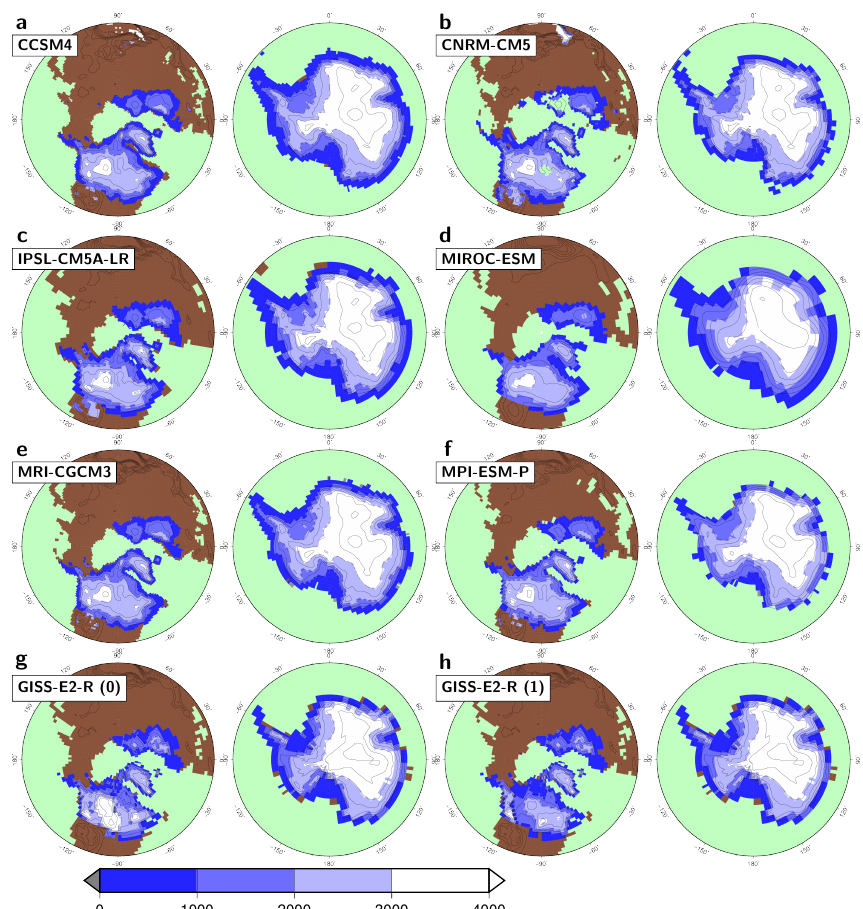
Figure 9. Implementation of the CMIP5/PMIP3 composite ice sheet in individual models. The plots show the surface elevation (m) as implemented in each model, and thus reveal that there are small differences in the prescribed ice sheet between models because of differences in e.g. model type and